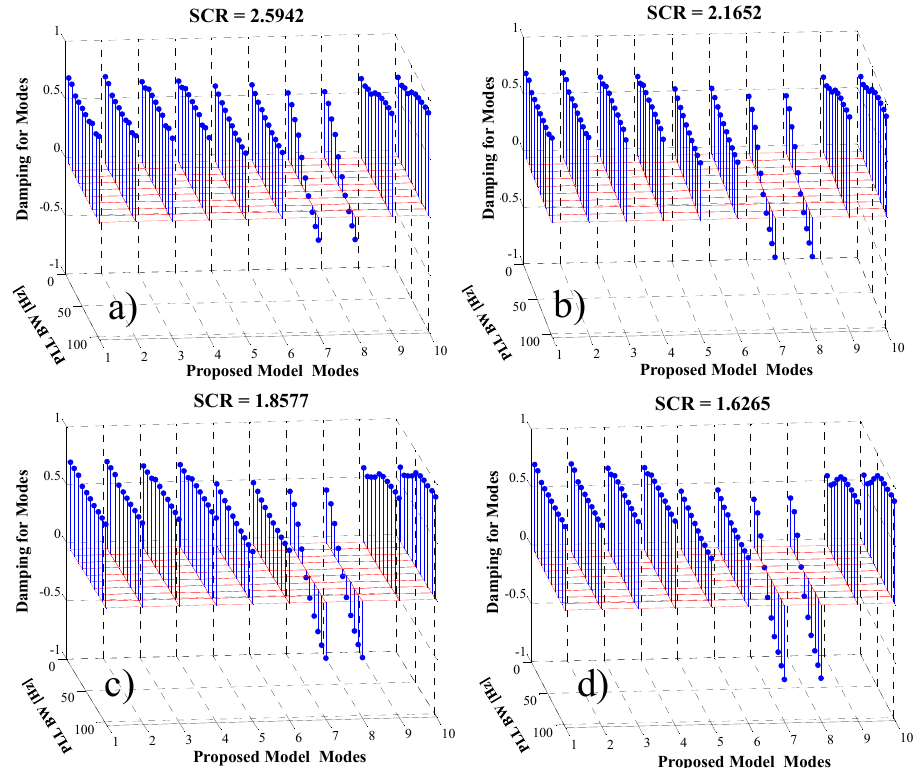
Figure 7. Damping of modes of the proposed small signal model as a function of the PLL bandwidth and the following short circuit ratios (SCR) of the weak grid: ( a ) SCR=2.5942; ( b ) SCR=2.1652; ( c ) SCR=1.8577; ( d ) SCR=1.6265